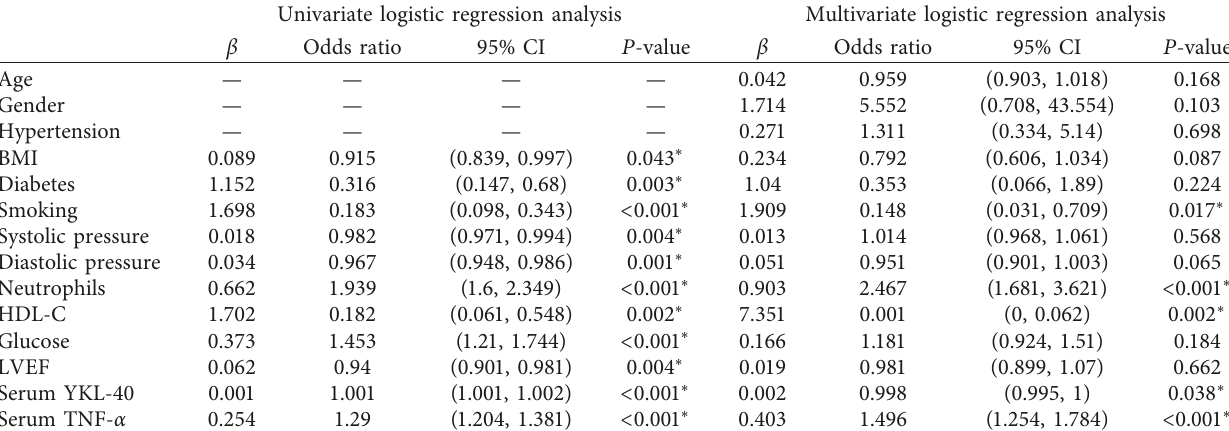
Table 2: Logistic regression analysis of risk factors for STEMI. Univariate logistic regression analysis